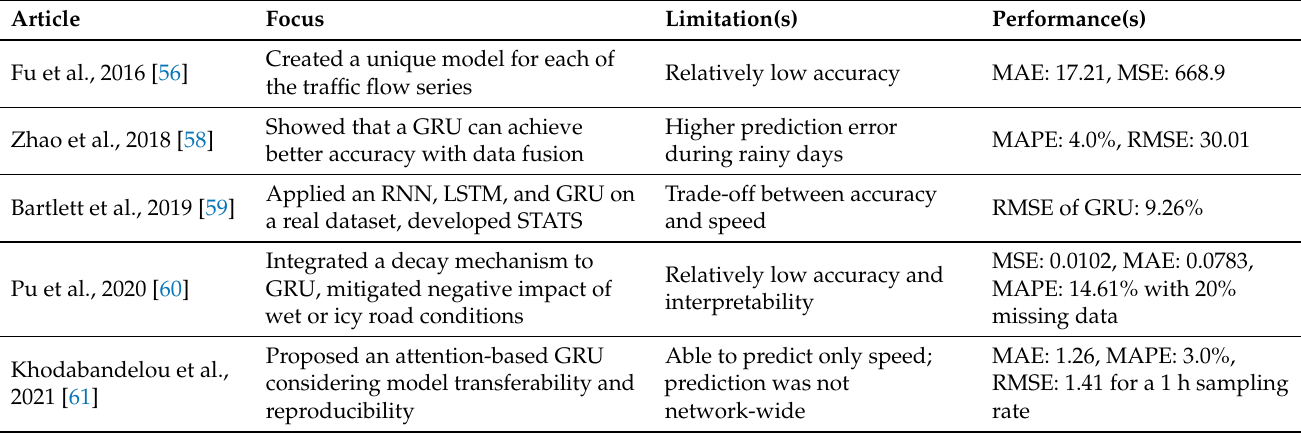
Table 7. Summary of the works found using GRU.